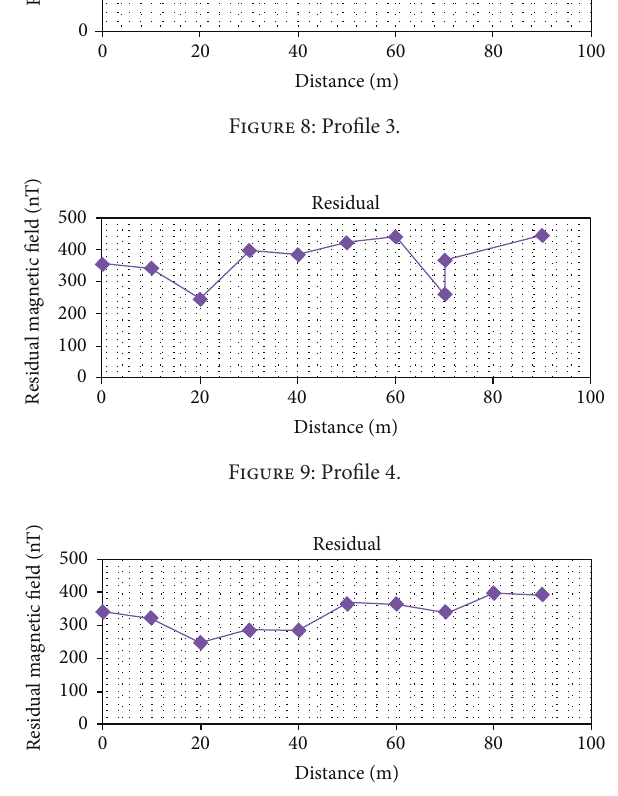
Figure 10: Profile